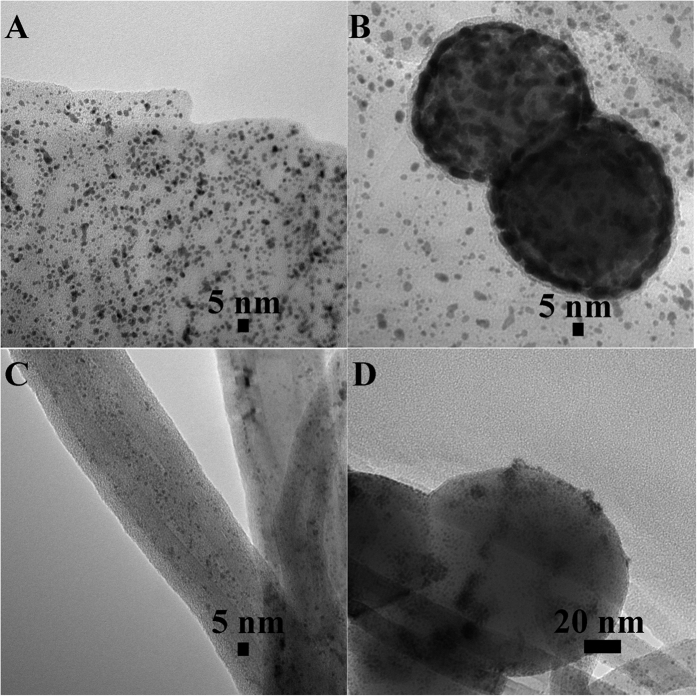
Morphology.TEM micrographs of Photo-Pt-graphite-TiO2 (A,B) Photo-Pt-CNT-TiO2 (C,D).